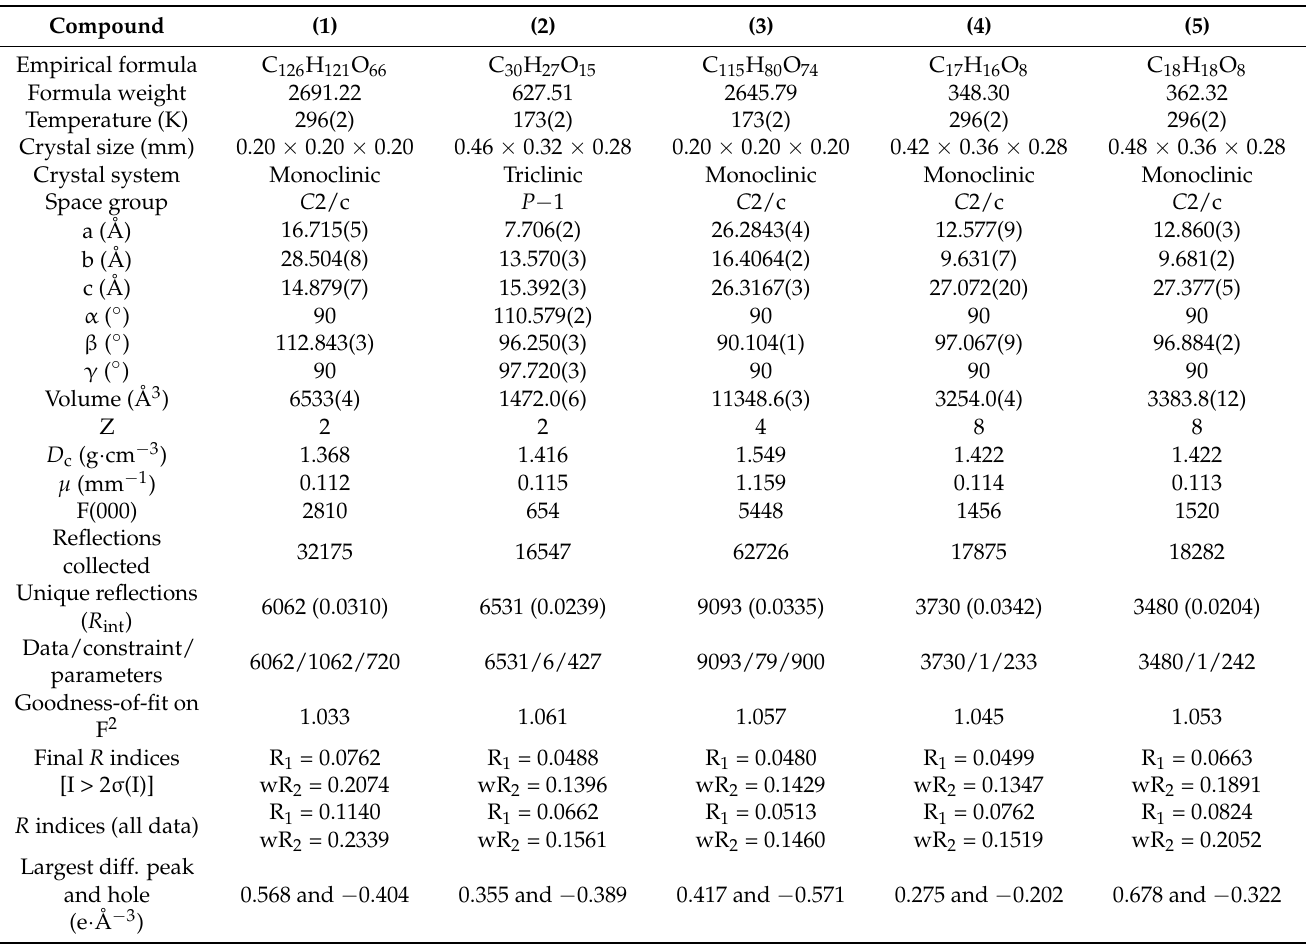
Table 1. Crystallographic